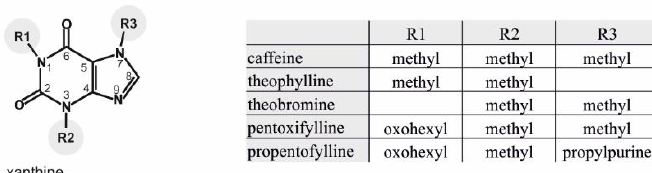
Figure 1. Chemical structure of xanthine ( left ) and combinations of the side chains of its derivatives caffeine, theophylline, theobromine, pentoxifylline and propentofylline ( right ).